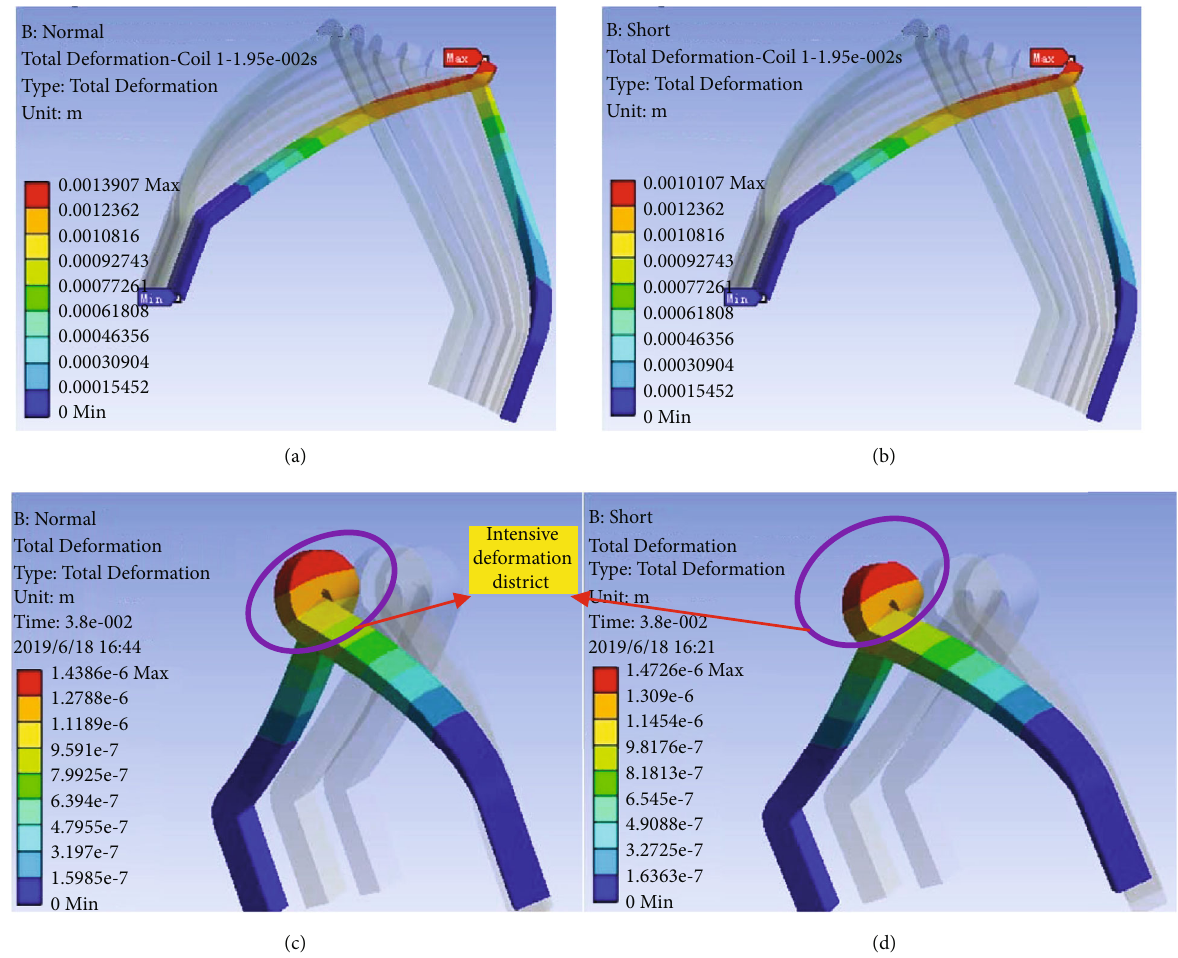
Figure 11: Deformation distribution before and after RISC: (a, b) QFSN-600-2YHG generator in normal and RISC, respectively; (c, d) MJF- 30-6 simulator in normal and RISC,